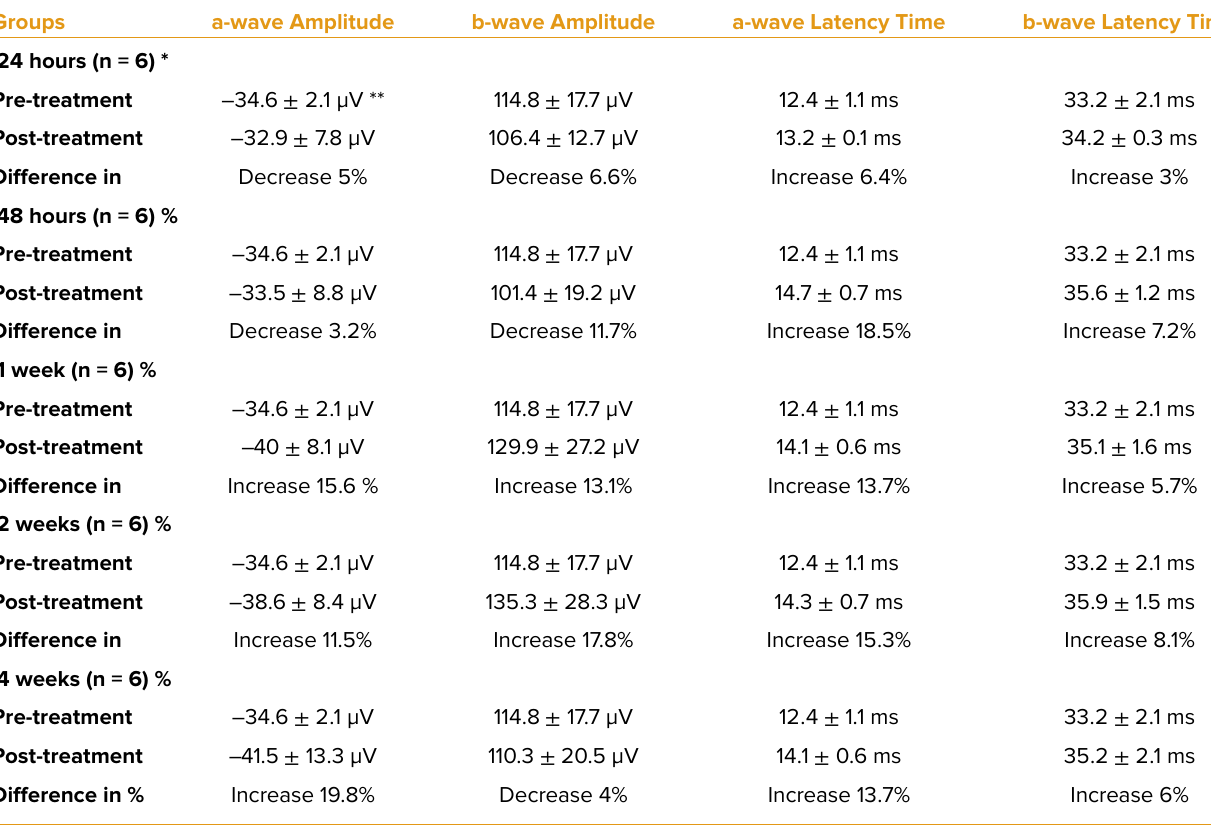
Table 4. The amplitudes and latency times of ERG waves from the Saline-treated rabbits (6 eyes)